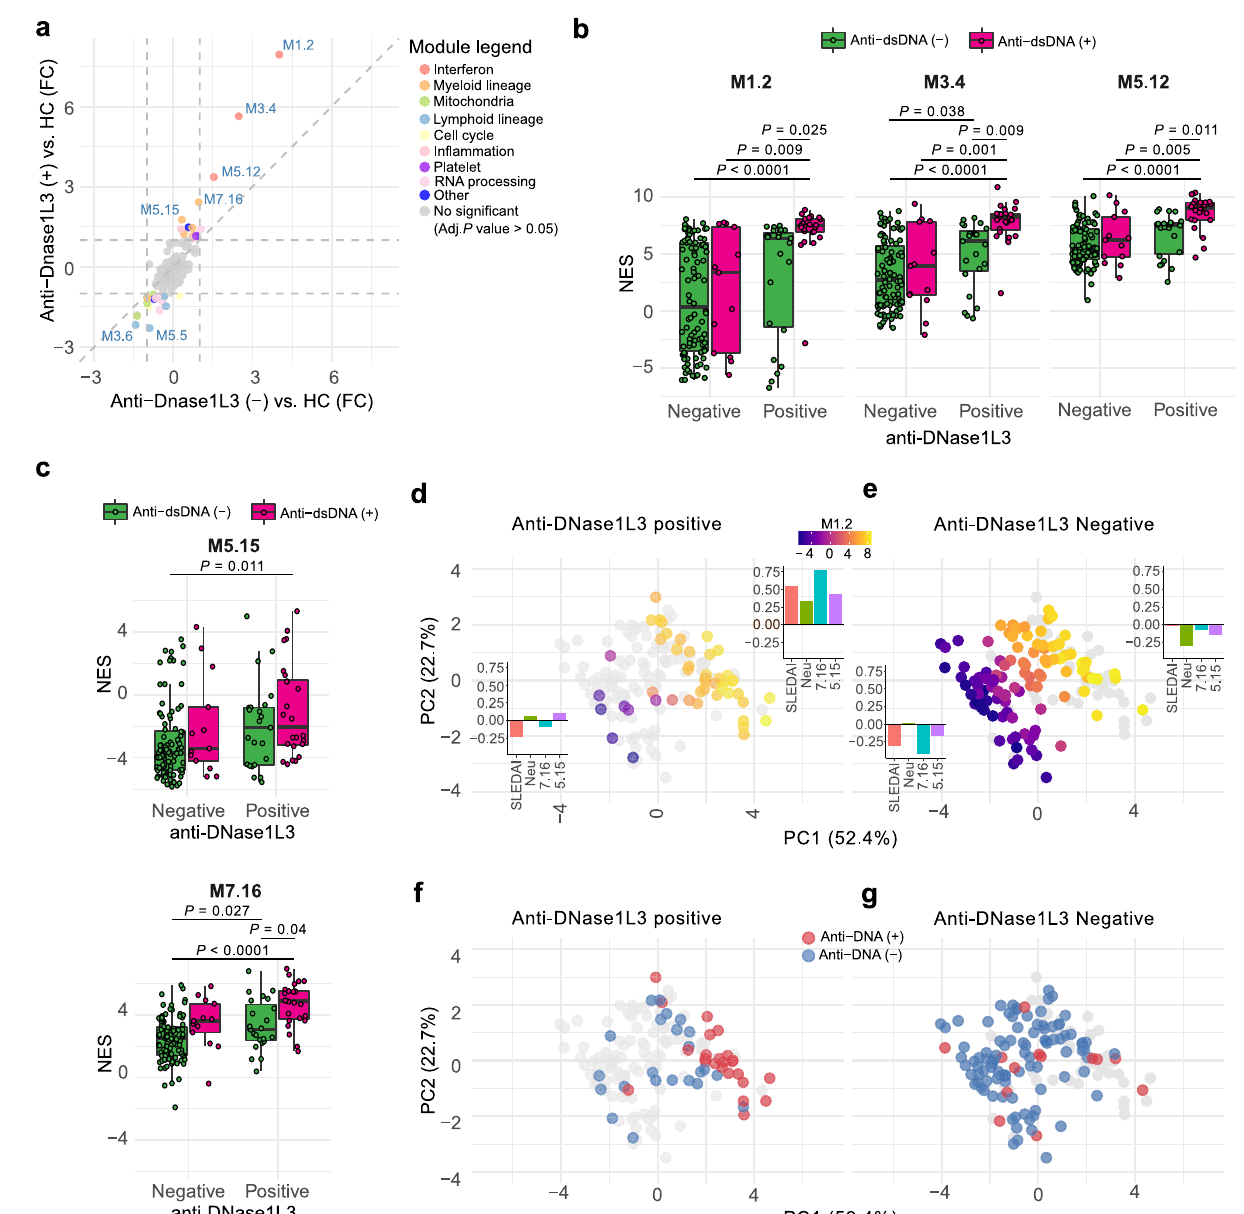
Fig. 3 | Transcriptional fi ngerprints associated with anti-DNase1L3 antibodies in SLE. a Four-way plot of the differentially regulated blood expression modules betweenanti-DNase1L3(+)SLE vs .healthycontrols(HC)(datafromSupplementary Table2),and anti-DNase1L3 ( − ) SLE vs . HC(data from Supplementary Table3).FC, Fold change. b , c Comparison of the ssGSEA normalized enrichment scores (NES) for the IFN modules M1.2, M3.4, and M5.12 ( b ), and the myeloid lineage modules M5.15andM7.16( c )inSLEpatientsaccordingtoanti-DNase1L3antibodypositivity. Variables were compared using two-way ANOVA with Tukey ’ s test as post-hoc. d , e PCAprojectionofthesigni fi